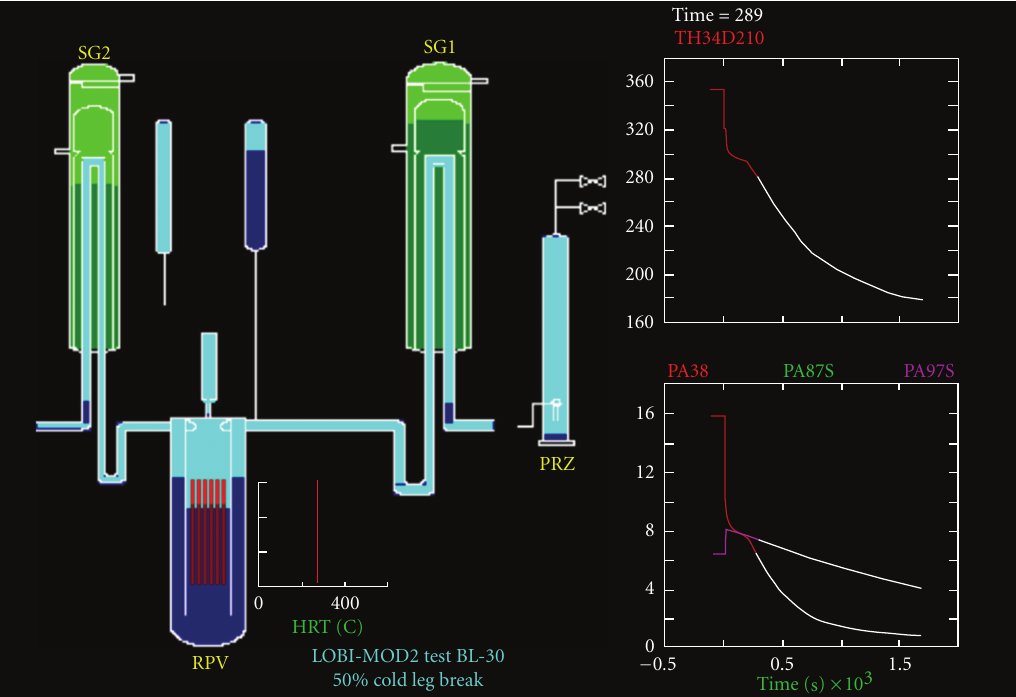
Figure 3: BL-30 experiment collapsed levels display and primary and secondary pressures (STRESA JRC database).